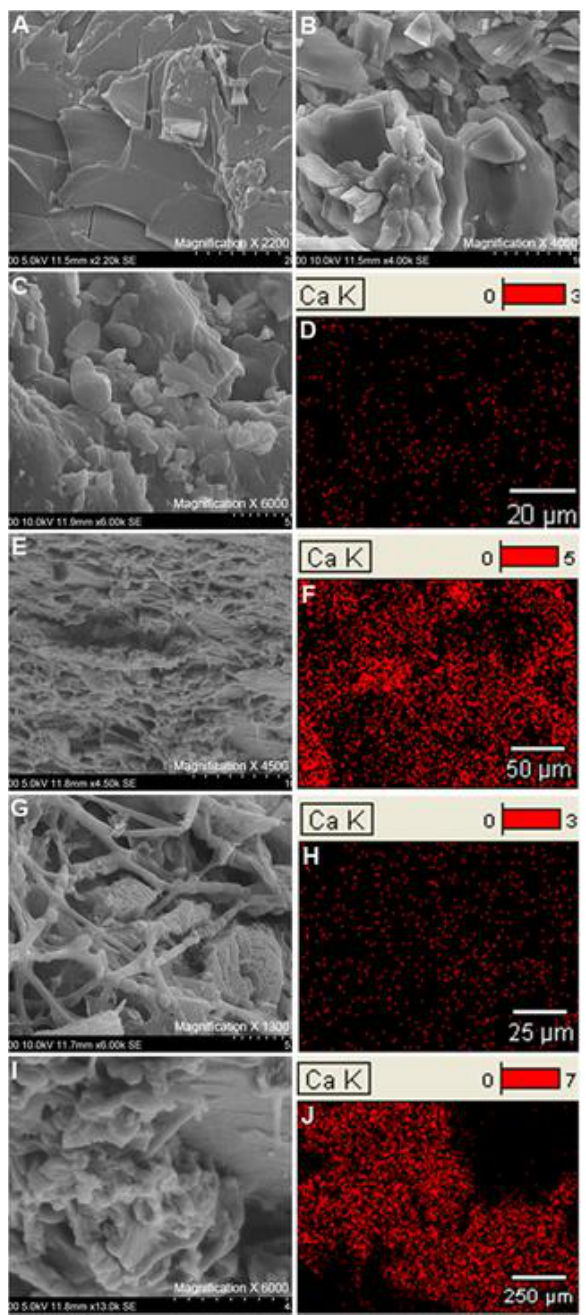
Fig 3. Microstructure and calcium distribution of different types of